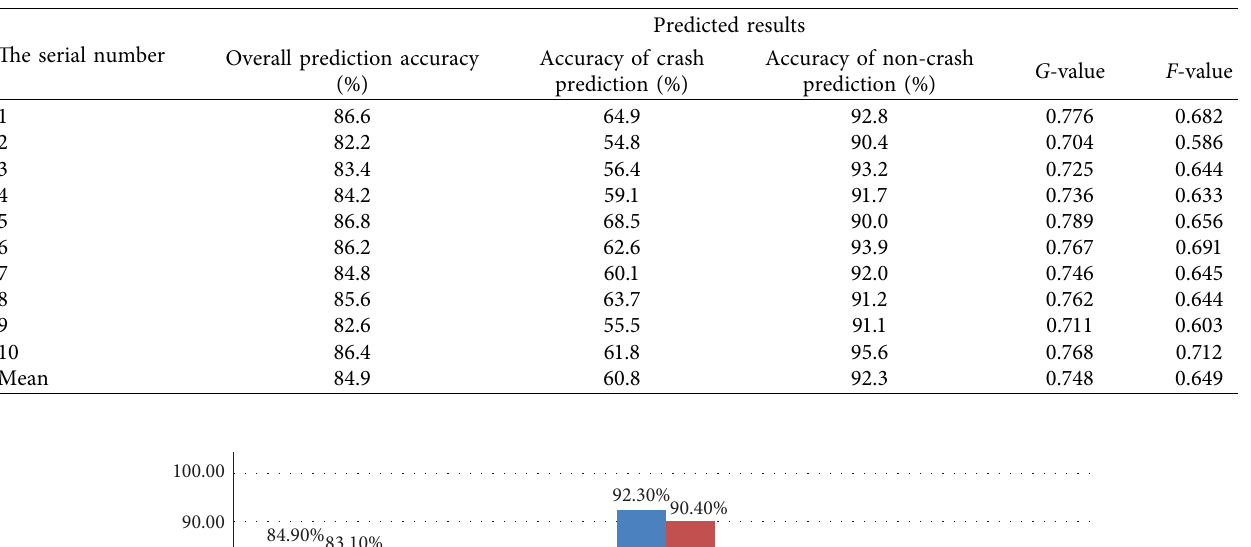
Table 4: Te confusion matrix of multiple prediction results.